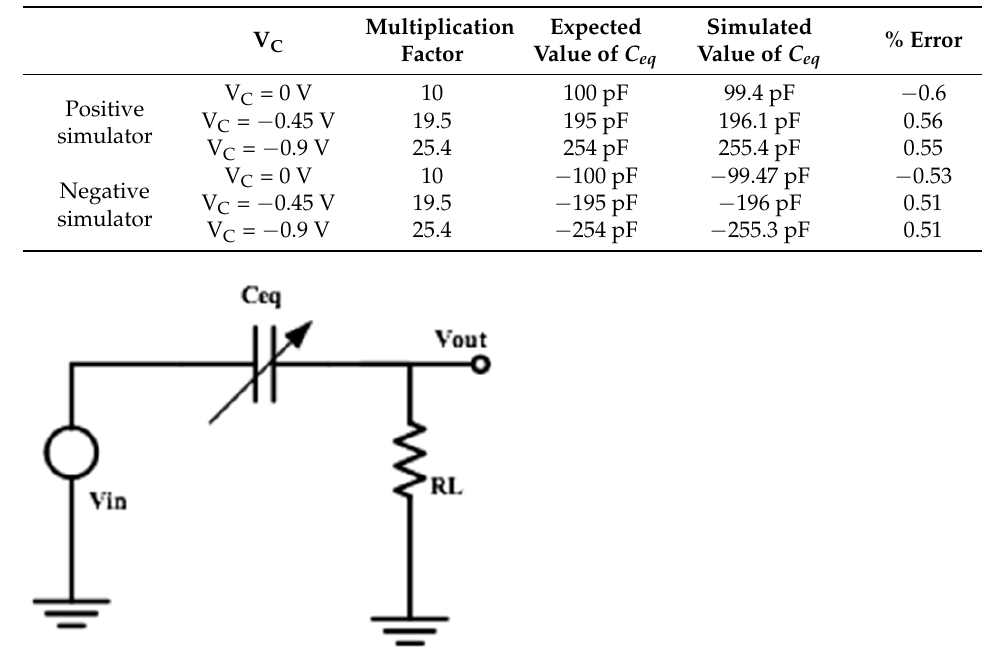
Figure 10. Frequency response of the high pass filter. Figure 9. Application of the proposed simulated floating C as a high pass Figure 9. Application of the proposed simulated floating C as a high pass filter.